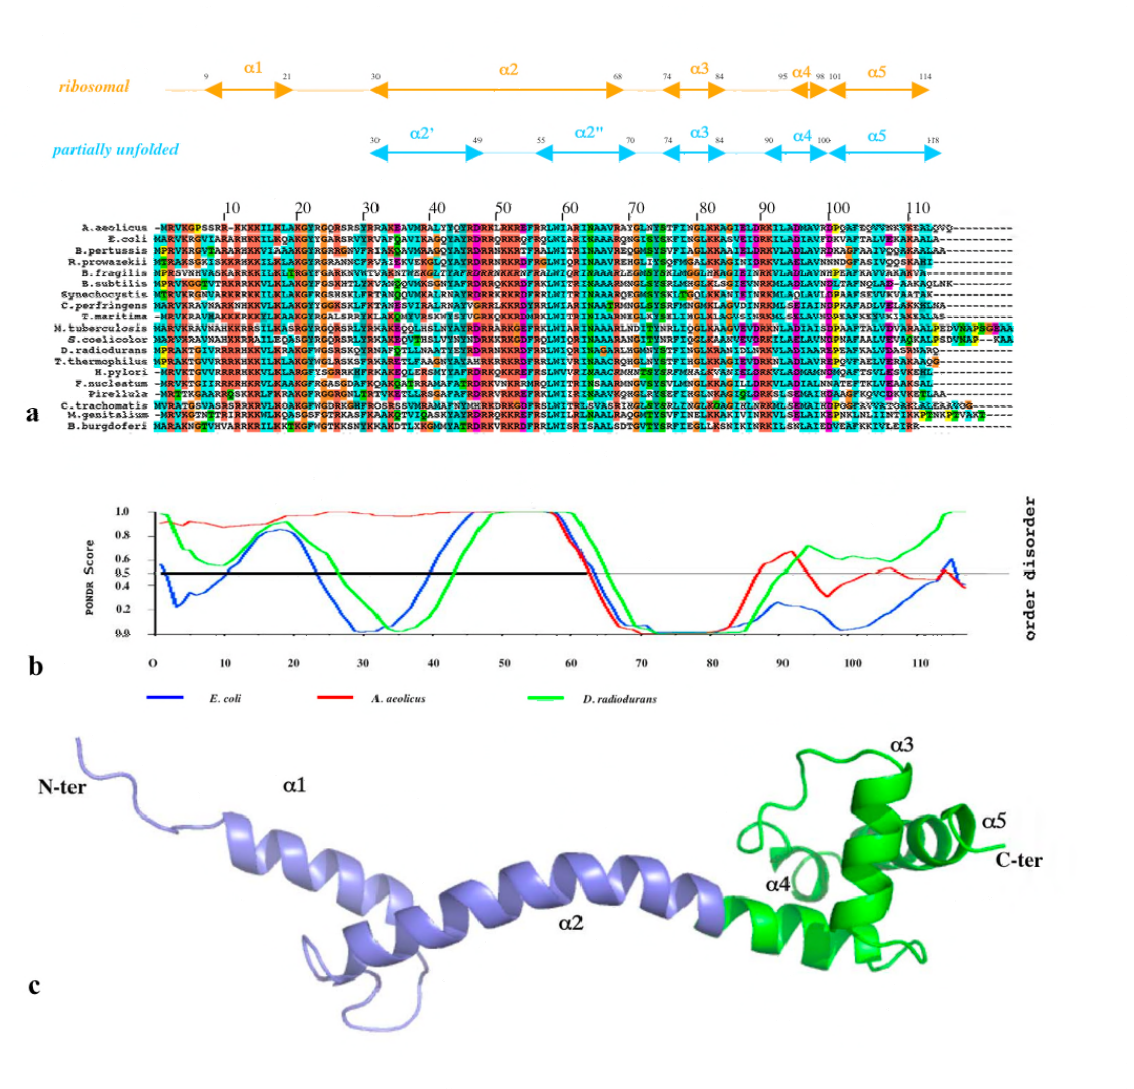
Figure 5. (a) Sequence alignment of the ribosomal protein L20 of representative species of eubacteria. The corresponding secondary structure elements are indicated above in cyan for the partially unfolded free crystal form and in orange for the folded ribosomal form. (b) Disorder prediction calculated with the program PondR for three species. Red: A. aeolicus . Blue; E. coli . Green: D. radiodurans. (c) Ribbon representation of the ribosomal form of T. thermophilus . The N-ter extension is represented in blue and the C-ter globular domain is represented in